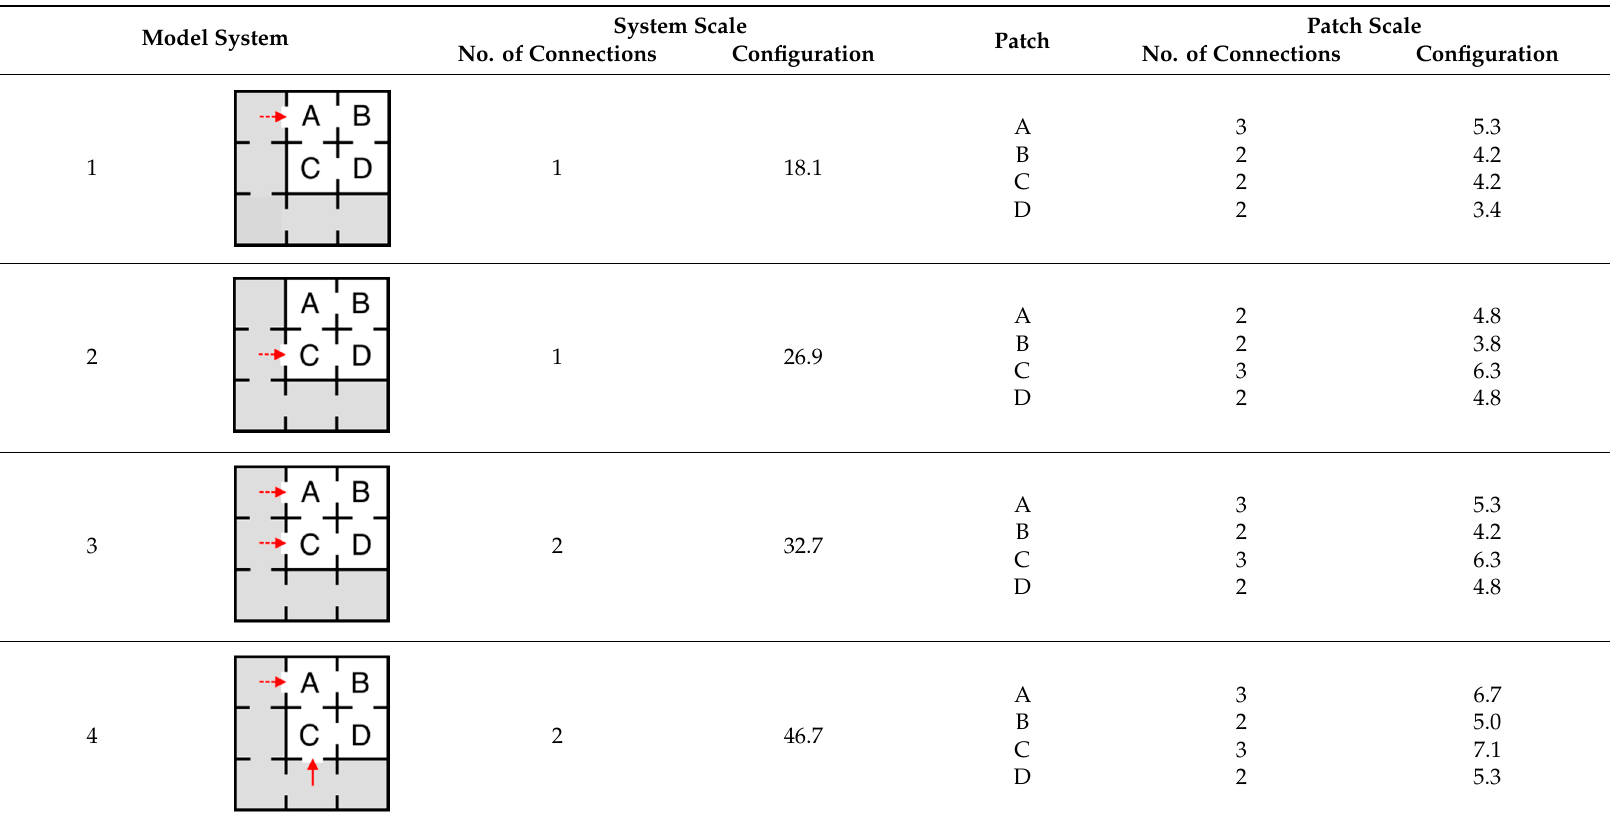
Table 1. Experimental system setups with patch- and system-scale connectivity values for the ‘number of connections’ and ‘configuration’ of the connections. Number of connections at the system scale is the number of links between disturbed patches (A–D) and undisturbed patches (grey), and number of connections at the patch scale is the number of neighbouring patches to the patch of interest (A–D). Values for configuration at the patch scale and system scale are calculated using an adaptation of the network theory measure of closeness centrality from Freeman [36]. Red arrows indicate open connections.